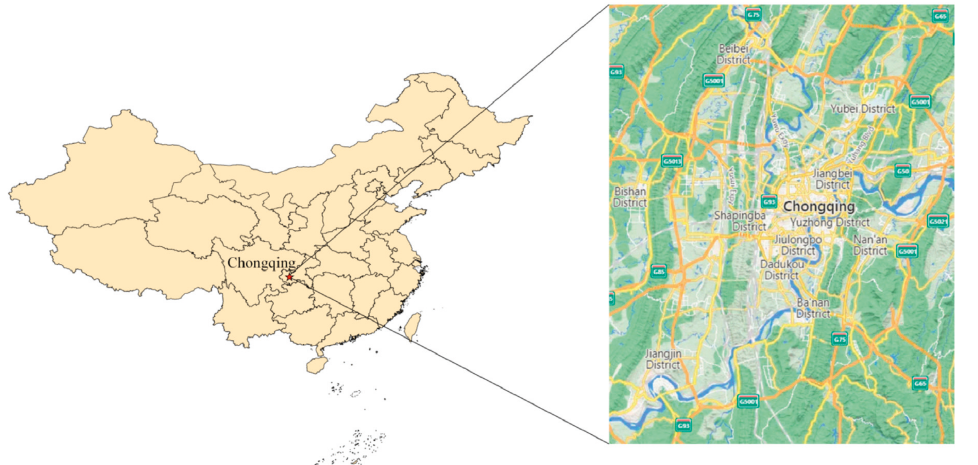
Figure 1: The location of Chongqing in China and its area.